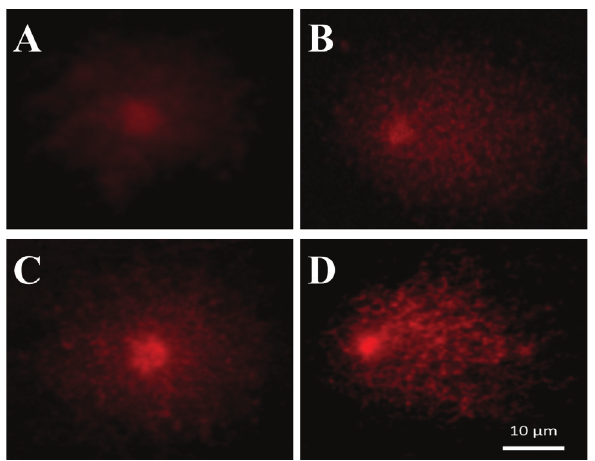
Figure 4 - Profiles of nucleoids observed in the comet assay in rice and common beans. A and C ) Nucleoids of O. sativa and P. vulgaris control embryos,respectively. B and D )nucleoidsof O.sativa and P.vulgaris em- bryos exposed to MMS,